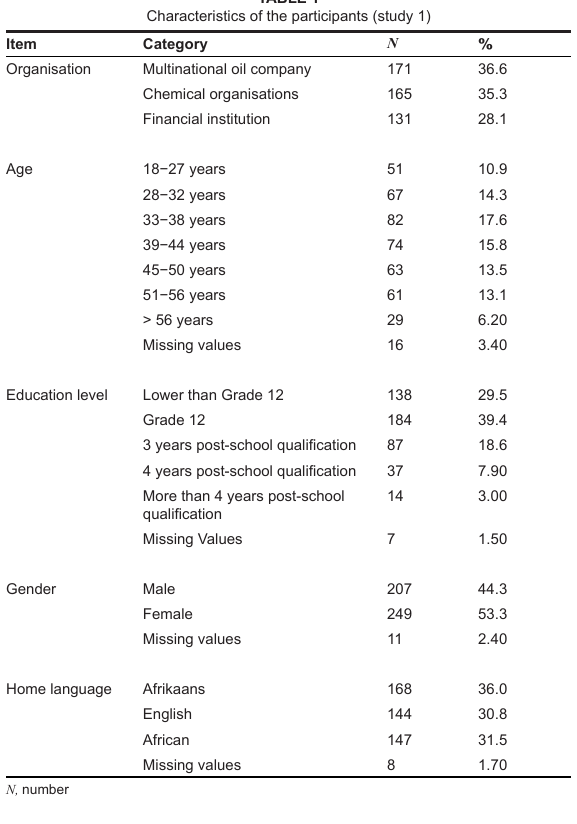
TABLE 1 Characteristics of the participants (study 1)